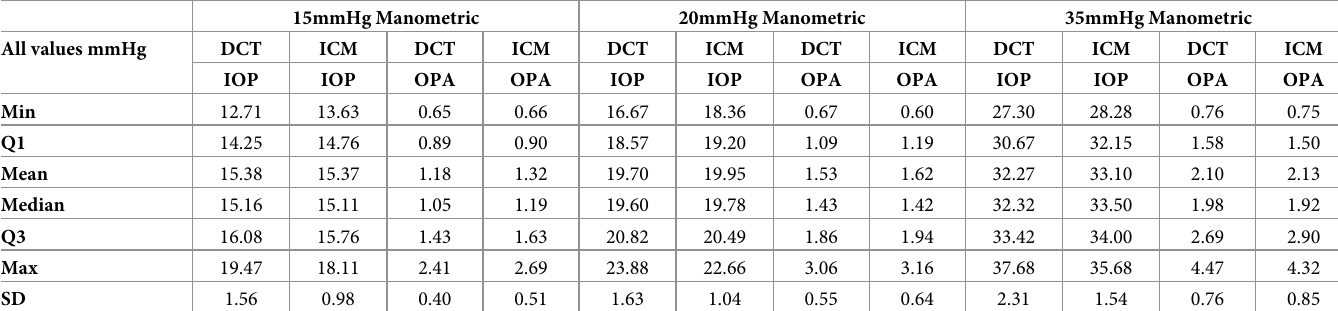
Table 1. Dataset IOP and OPA descriptive statistics.